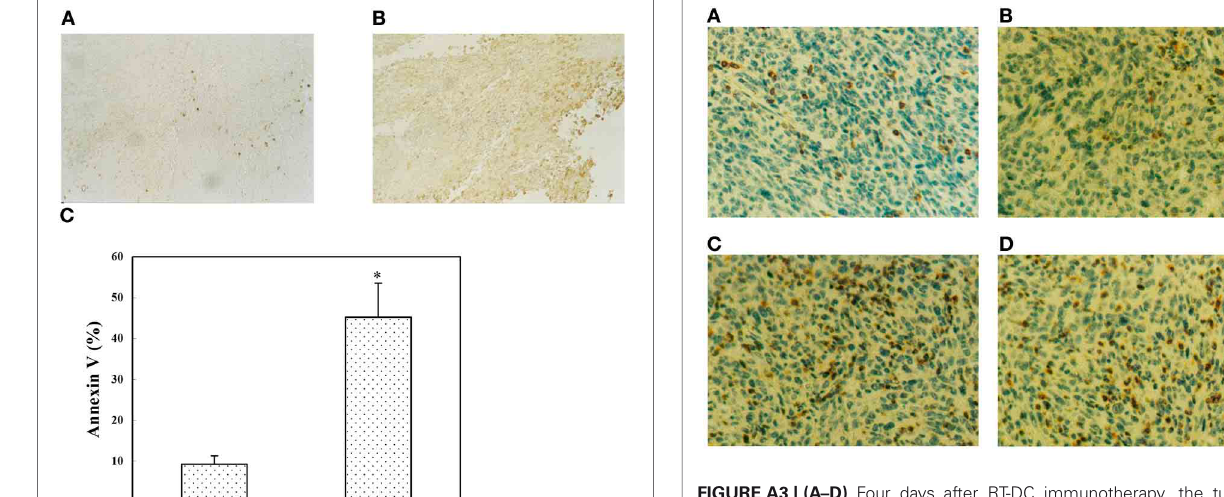
FIGURE A3 | (A–D) Four days after RT-DC immunotherapy, the tumor were removed and analyzed by immunohistochemistry. CD3 + T cell infiltration is seen as brown spots in the section counterstained with hematoxylin (magnification, 400 × ). Sections are from mice treated with PBS (A) , BM-DCs alone (B) or BM-DCs plus 50 μ g of rHsp70 (C) or rHsp70C (cid:5) -PSA (D)